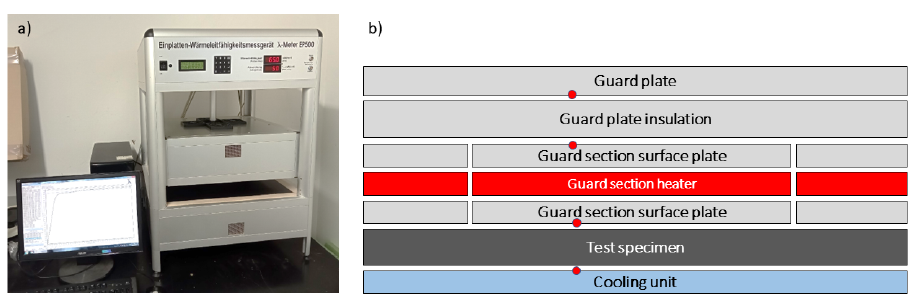
Figure 3. The test apparatus for the determination of the panel equivalent thermal conductivity